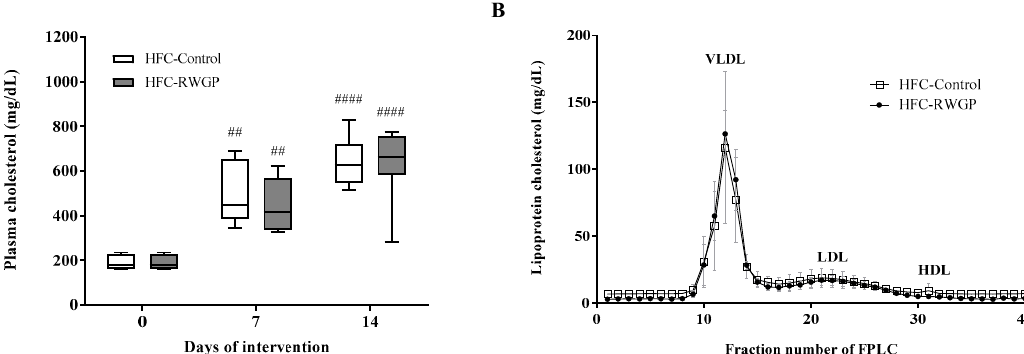
Figure 2. E ff ect of RWGP supplementation on plasma total and lipoprotein cholesterol levels of SR-B1 KO / ApoER61 h / h mice fed with atherogenic diet. ( A ) Data for total plasma cholesterol are shown in box plots (box, 25th to 75th percentiles; whiskers, median and interquartile range (IQR)) ( n = 5–7). ## p < 0.01 and #### p < 0.0001 compared to day 0 based on two-way ANOVA. ( B ) Distribution of cholesterol content in plasma lipoproteins. Data represent averages and error ( n = 5–7).